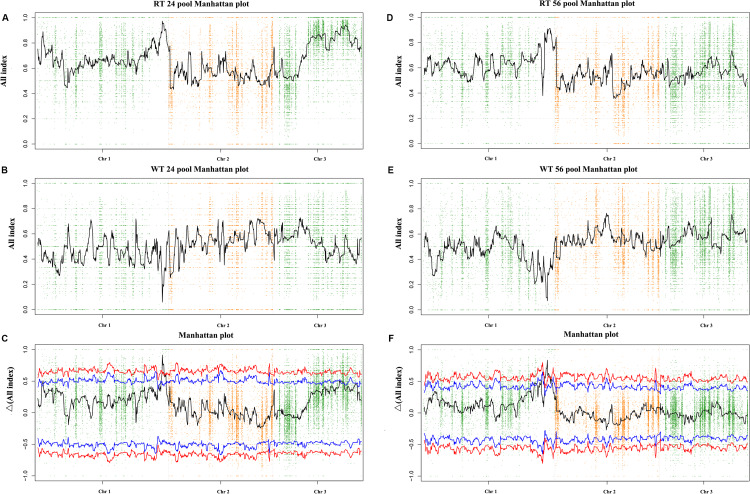
Δ(All-index) graphs from QTL-seq analysis. The Δ(All-index) plot with statistical confidence intervals under the null hypothesis of no QTL (red, P < 0.01; blue, P < 0.05). The X-axis represents the position of 3 chromosomes, and the Y-axis represents the Δ(All-index). The Δ(All-index) was calculated based on a 1-Mb interval with a 100-kb sliding window. (A–C): RT24-WT24, and (D–F): RT56-WT56.